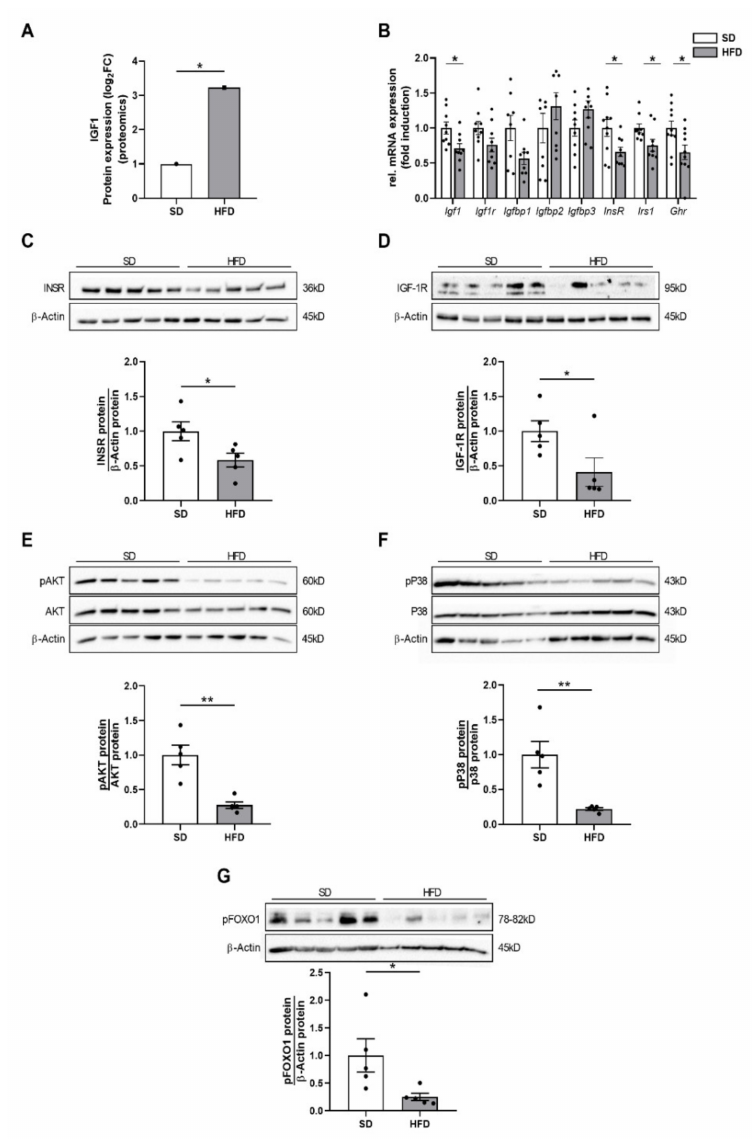
Figure 3. Perinatal obesity inhibits hepatic insulin/IGF-1 signaling. ( A ) IGF-1 protein expression in proteomic analysis at P21. ( B ) Measurement of genes encoding for IGF-1 ( Igf1 ), IGF-1 receptor ( Igf1r ), insulin-like growth factor-binding proteins 1–3 ( Igfbp1-3 ), insulin receptor ( Insr ), insulin receptor substrate ( Irs1 ), and growth hormone receptor ( Ghr ) using quantitative real-time PCR (n = 10 per group). ( C,D ) Assessment of insulin receptor (INSR; C ) and IGF-1 receptor (IGF-1R; D ) protein abundance in liver homogenates using immunoblots. (E-G) Assessment of insulin/IGF-1 signaling pathway using immunoblot: phosphorylated AKT (pAKT) and total AKT protein expression ( E ); phosphorylated P38 (pP38) and total P38 MAP kinase protein expression ( F ); and phosphorylated FoxO1 protein abundance ( G ). β -Actin served as loading control; pAKT and pP38 were related to total AKT and total P38, respectively; pFoxO1 was related to β -Actin. Densitometric analyses are displayed below the respective immunoblots. Immunoblots: SD group (n = 5), HFD group (n = 5). Data are presented as mean ± SEM; * p < 0.05, ** p < 0.01. FoxO1, Forkhead-Box-O-1 transcription factor; HFD, high-fat diet; IGF-1, insulin-like growth factor 1; Igfbp, insulin-like growth factor-binding protein; Igfr, insulin-like growth factor receptor, Insr, insulin receptor; Irs1, insulin-receptor substrate 1; p, phosphorylated; P38, mitogen-activated protein kinase (MAPK) p38; SD, standard